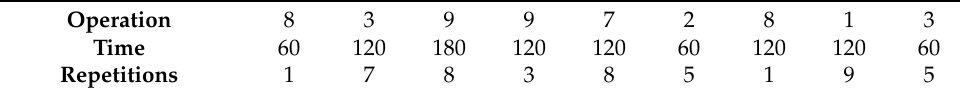
Figure 11. Changes of thermal stress in the drum boiler over time with the benchmark solution. Table 3. Best solution obtained with the metaheuristic hybrid algorithm and a randomly gener- ated initial-solution.